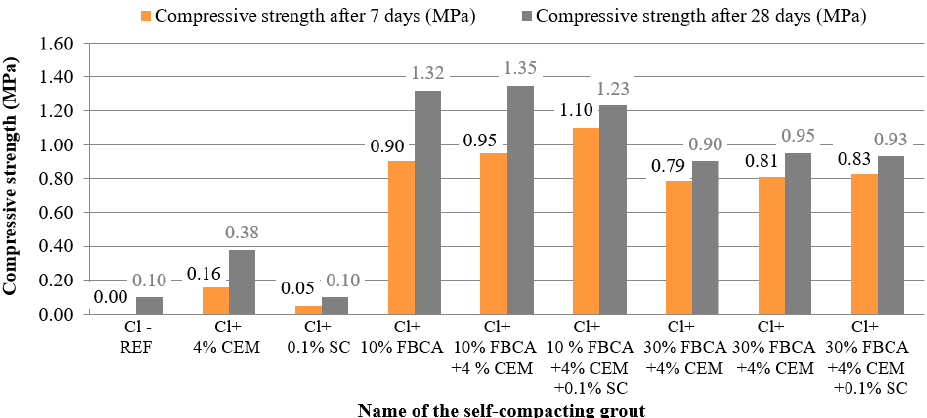
Figure 6. Compressive strengths of self-compacting grouts using FBCA and sodium carbonate (SC), after seven and 28 days of maturation.